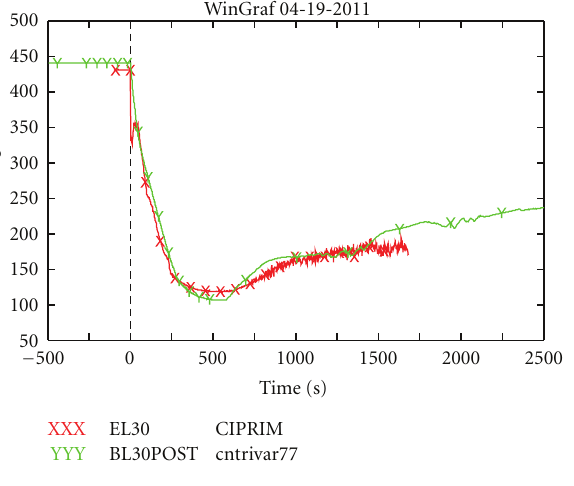
Figure 7: Primary system mass.